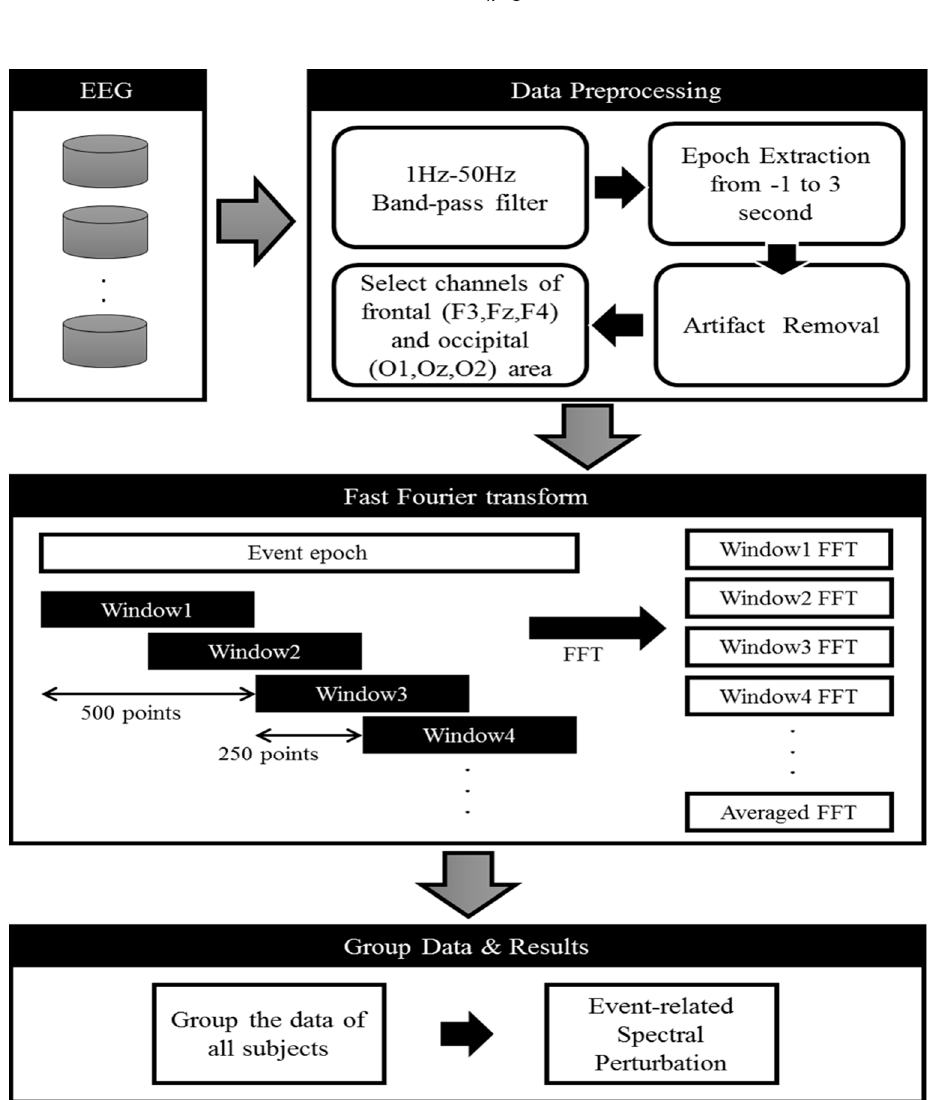
Figure 3. Flowchart of EEG analysis during mental focus and lost-in-thought states.